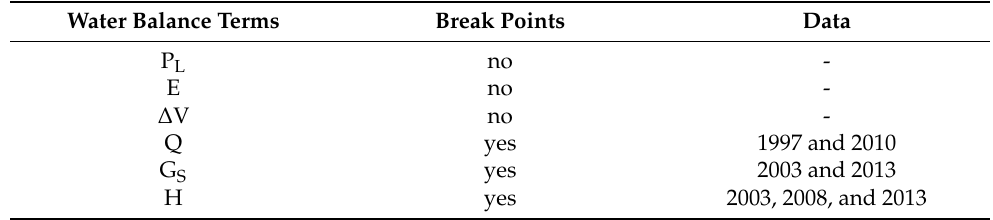
Table 1. Results of break point analysis on monthly main water balance terms adjusted for seasonality.